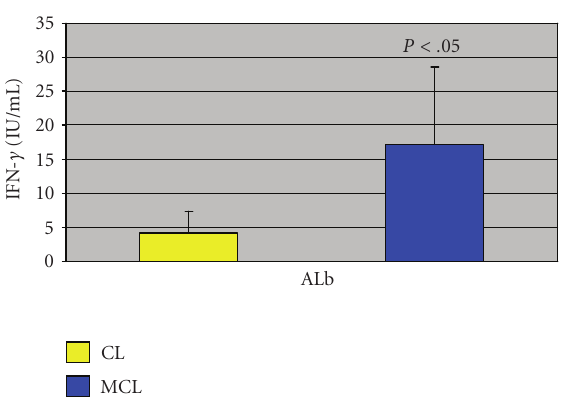
Figure 2: IFN- γ production in cell-free supernatants of CL and MCL patients’ PBMCs measured by ELISA upon ALb stimulation.